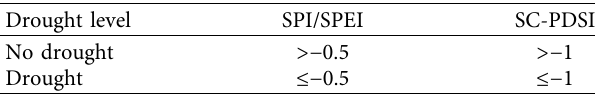
Figure 1: The locations of the study area and the six Table 1: Drought classifications for SPI, SPEI, and SC-PDSI.